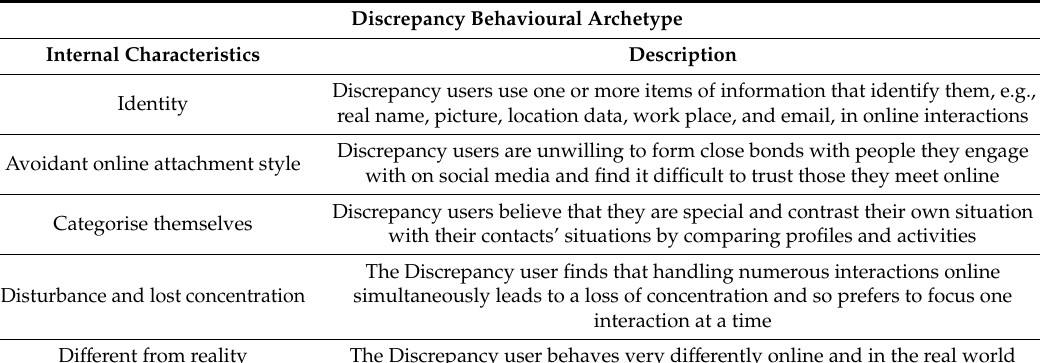
Table 9. Overview of the Discrepancy behavioural